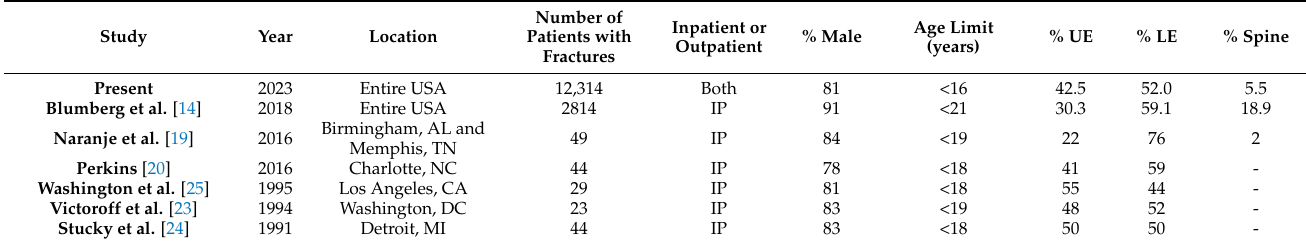
Table 7. Compilation of the literature regarding firearm-associated fractures in